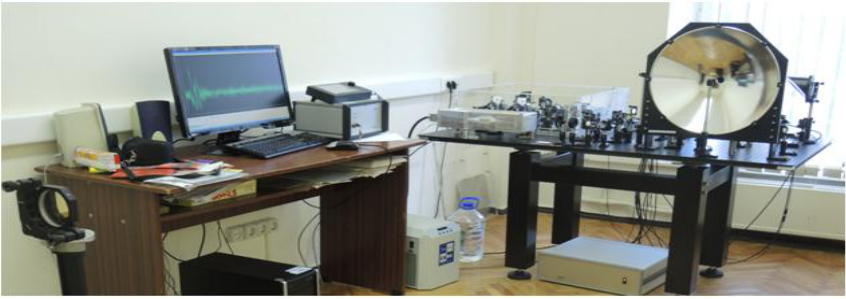
Figure 1. Experimental setup for THz signal measuring at long distance [29].